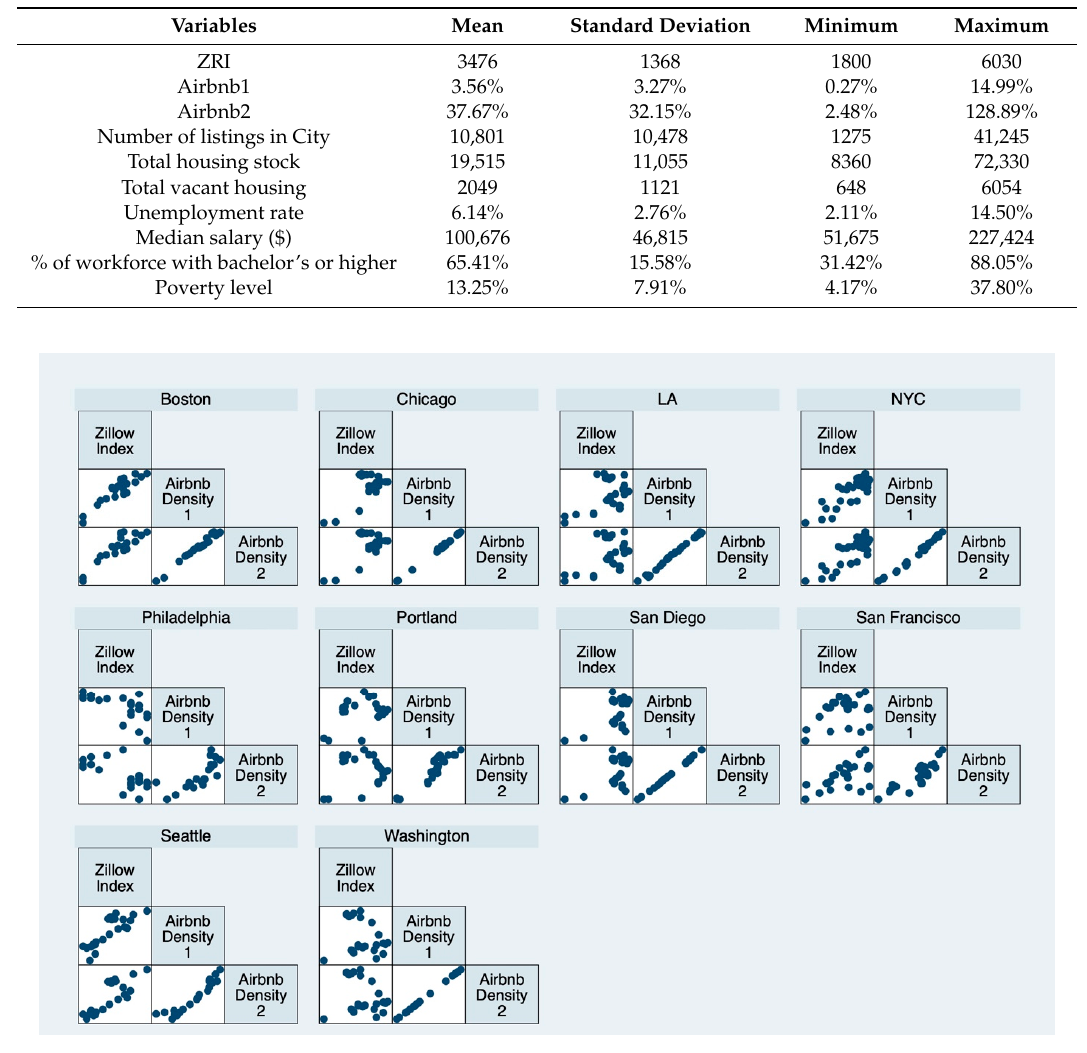
Figure 1. Correlation between property price index and Airbnb density in ten American cities.